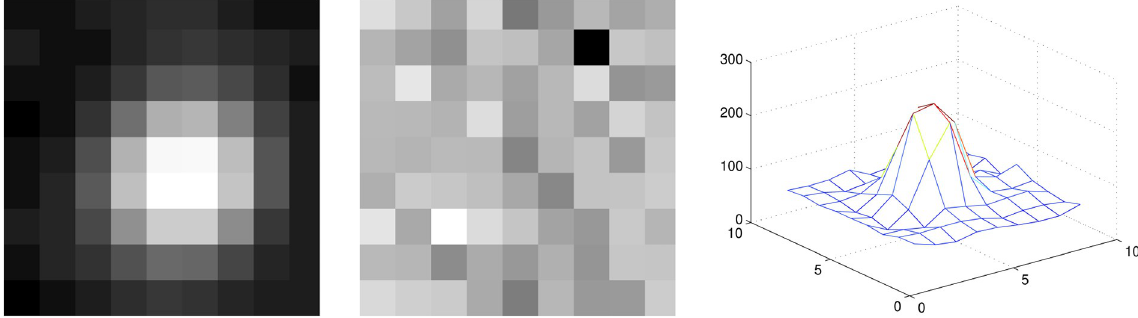
Fig 3. LDA prototypes for cell and background and mesh showing the topology of a cell. The images show the result of averaging patches containing a cell in the center (left), and containing background information (middle). Cells show a gaussian-like distribution while noise follows a uniform distribution